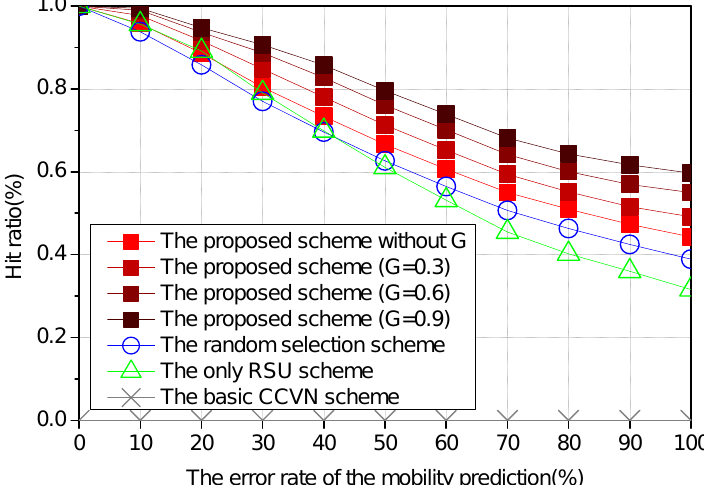
Figure 7. The hit ratio for the error rate of the mobility